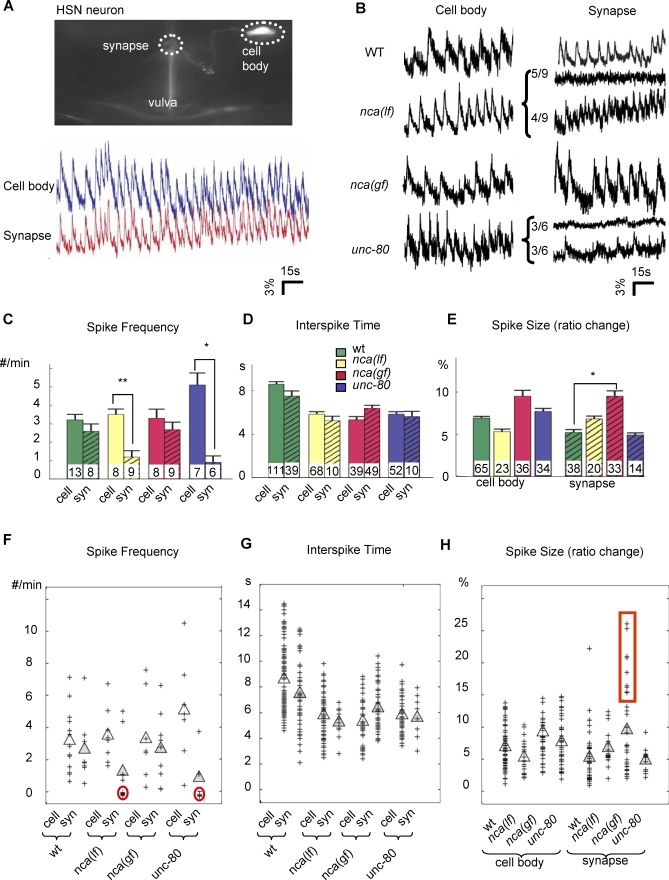
Ca2+ Transients at HSN Cell Bodies and Synapses in nca(lf), nca(gf), and unc-80 Mutants(A) Upper panel: Image of HSN neuron used in calcium imaging. The HSN cell body and the synapse where Ca2+ imaging were performed are circled in dots. Lower panel: Sample traces of simultaneous recording of calcium spikes of both cell body and synapse, showing the synchronicity of the calcium signals.(B) Sample traces of yellow/cyan ratio that represent the relative Ca2+ concentration in HSN cell bodies (left panels) or their synapses (right panels). x-axis: time in s; y-axis: yellow/cyan ratio in percent. For nca(lf) and unc-80, animals displayed traces with either silent (top) or active (bottom) Ca2+ transients.(C–E) Histograms for the total spike frequency, spike interval, and size of calcium spikes detected in each strain. Arrowheads: examples of calcium spikes. The number of animals examined, n, (C) or the number of calcium spikes examined (D, E), is illustrated at the bottom of each bar. Error bar: SEM. *p < 0.05, **p < 0.005. (C) Average number of spikes/min for each genotype. There is no statistically significant difference for HSN cell bodies (cell) among all strains, or between HSN cell bodies (cell) and synapses (syn) of the same strain except for nca(lf) and unc-80. (D) Average time interval between two consecutive spikes within trains of calcium transients. There is no statistically significant difference between HSN cell bodies and corresponding synapses for all strains. (E) Average spike size. Wild-type, nca(lf), and unc-80 neurons displayed no statistically significant difference in spike size, but for the nca-1(gf) neurons, it was increased.(F–H) Scatter plots for spike frequency, interspike time interval, and spike size. Each cross represents a data point. Clear and filled triangles represent mean numbers for cell body and synapse calcium transients, respectively. Red circles highlight populations of animals with silenced synapse calcium transients. Red box highlights a population of nca(gf) synapse spikes that were significantly larger than those seen in other genotypes. All statistic analysis was performed by Kolmogorov-Smirnov rank test.